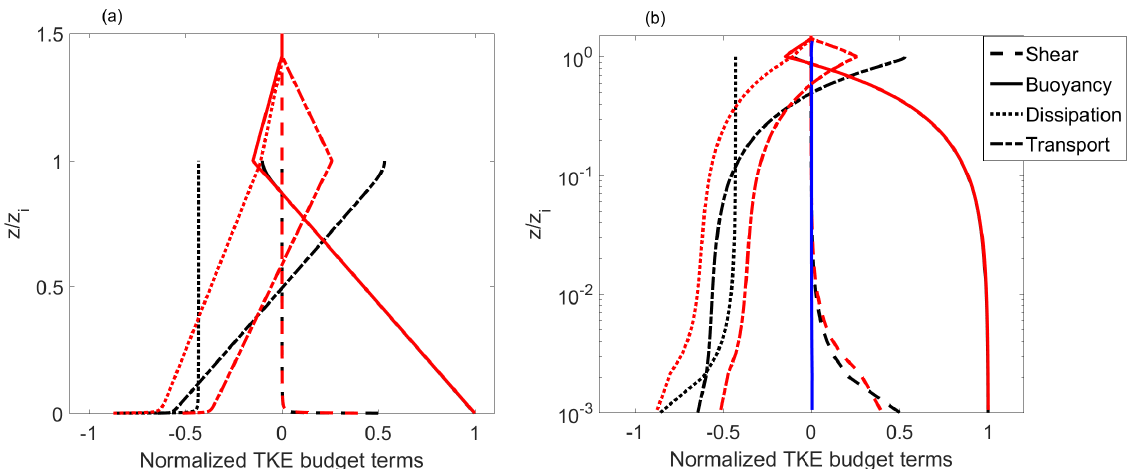
Figure A1. Normalized terms in the turbulence kinetic energy equation from Lenschow (1974) (in black) and from our model (in red) for a convective case with z i /L equal to − 1000, z i ≈ 1000m and a surface roughness length z 0 = 0 . 02m. Buoyancy production, shear production, dissipation and transport are shown with full, dashed, dotted and dash-dotted lines, respectively, for normalized height z/z i in panel (a) and with a logarithmic y axis in panel (b) . The TKE tendency term in our model is shown in blue in panel (b).